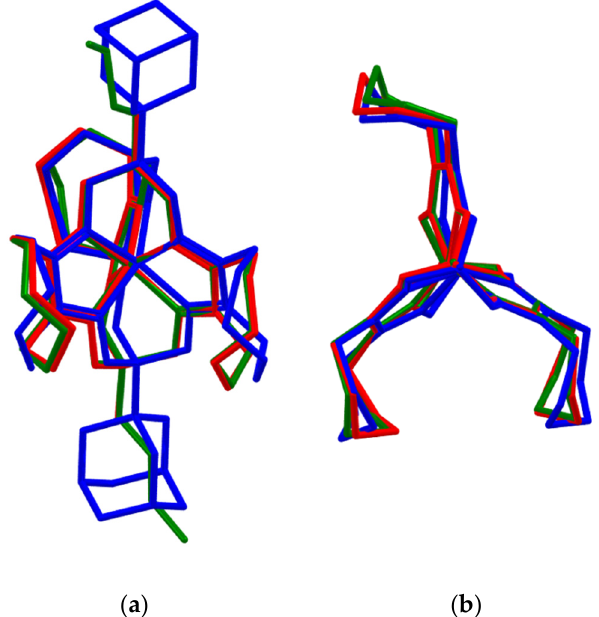
Figure 11. Superposition of the side ( a ) and top ( b ) views of the molecules FeOx 3 (BCH 3 ) 2 ( 5 , shown in red), FeOx 3 (B n -C 4 H 9 ) 2 (shown in green) and FeOx 3 (BAd) 2 (shown in blue) used for their comparison. Hydrogen atoms are omitted for clarity. Their main superimposed atoms are Fe1, B1, B2 and six nitrogen atoms as well.